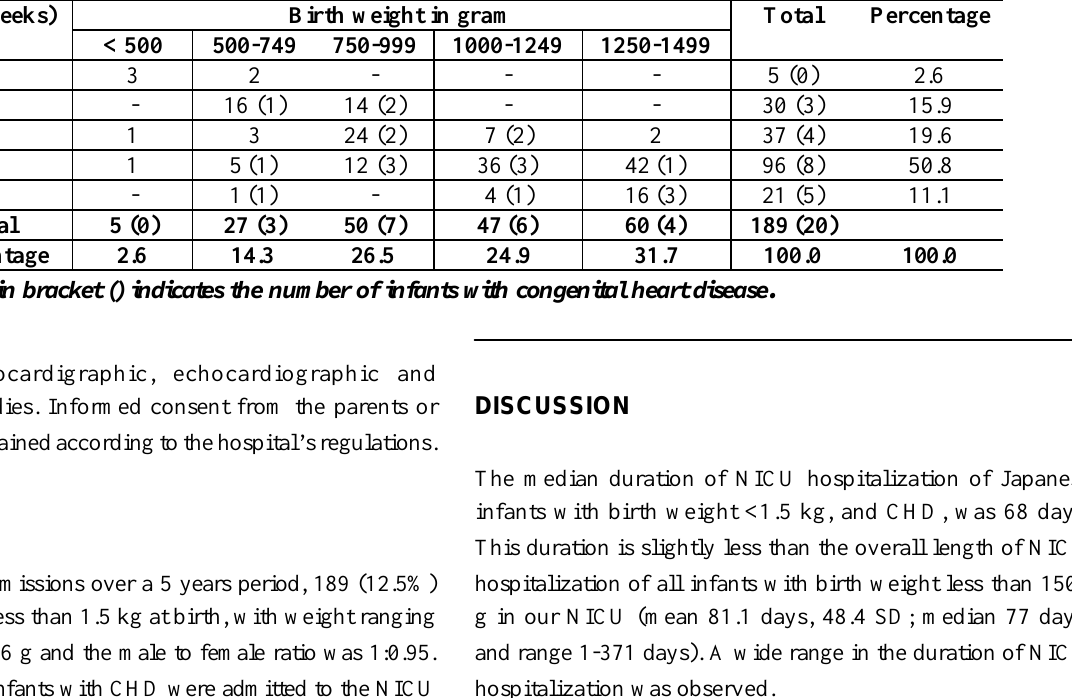
Table I : Distribution of birth weight and gestational age (GA) in all infants weighing less than 1500g and infants